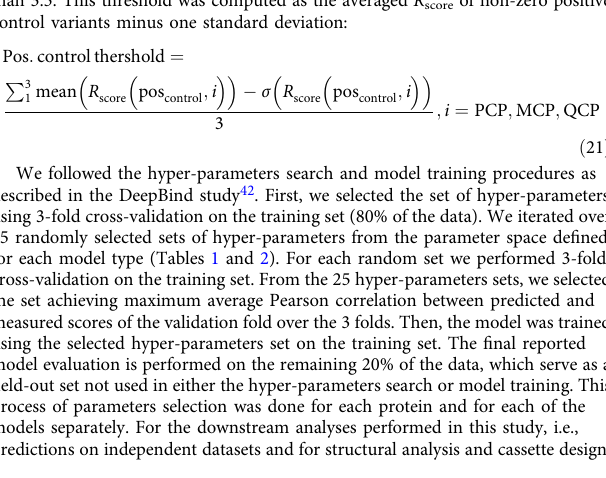
Table 1 Hyper-parameters search space for WT-speci fi c model.